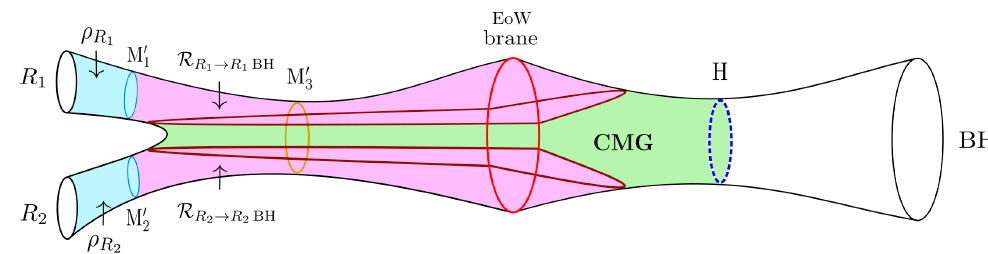
Figure 11. Classical Markov recovery. The pink region denotes the volume enclosed by the infalling geodesics from radiation subsystem R 1 and R 2 . The shaded green region is the classical Markov gap explained in the main text. Here we assume that two observers sitting at R 1 and R 2 exits can communicate classically, but neither they have the full control over both the exists